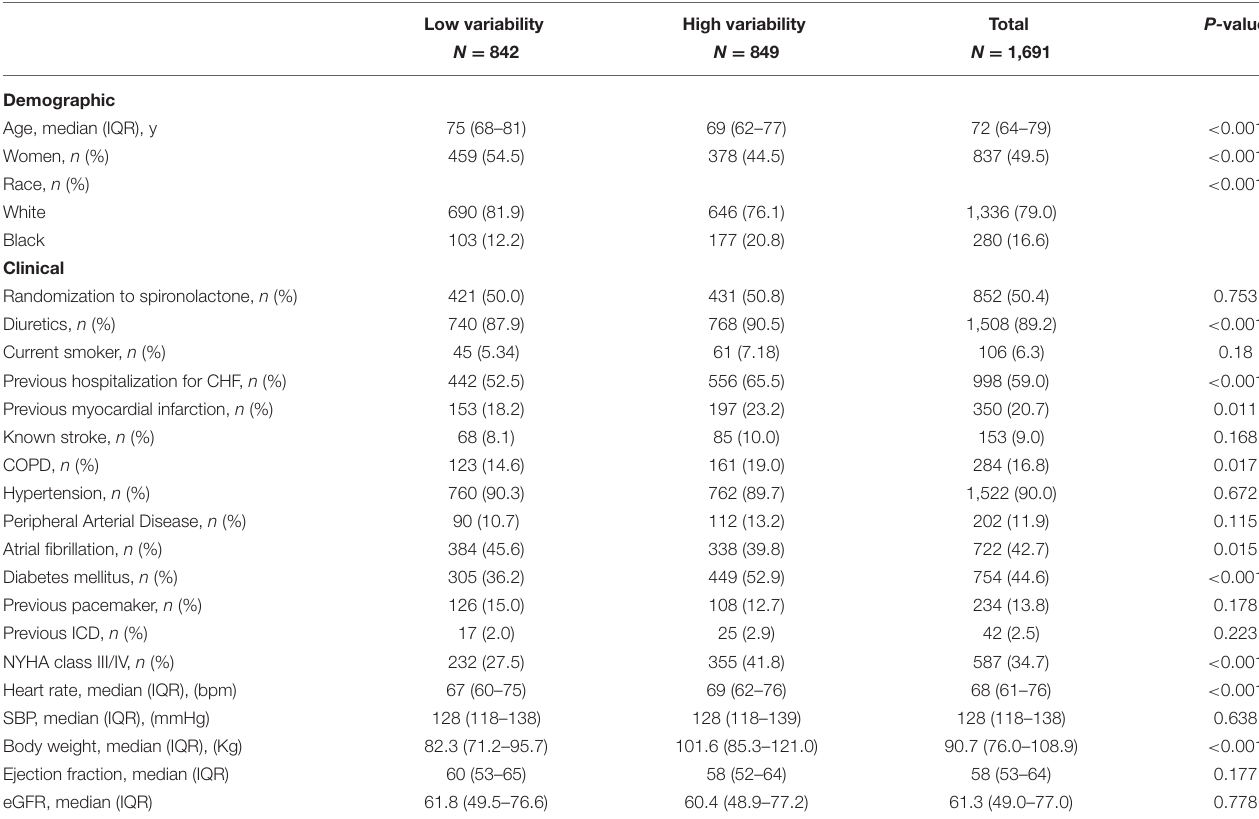
TABLE 1 | Characteristics of the patients by body-weight variability